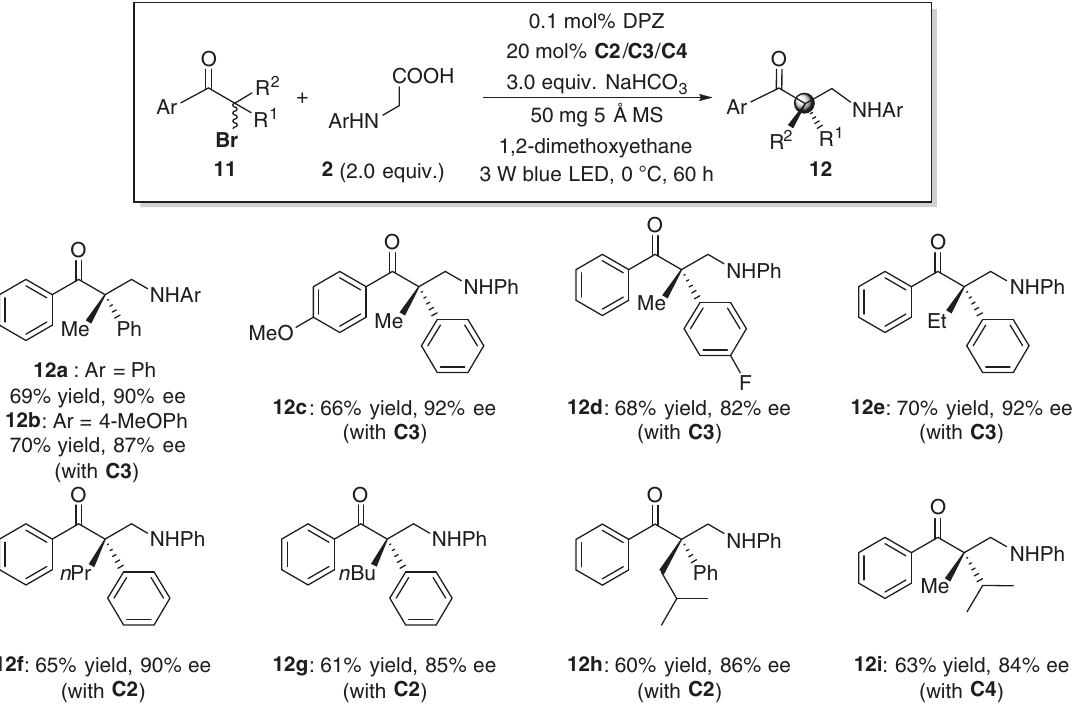
Fig. 4 Substrate scope of tertiary α -bromoketones. Reactions were performed with 7 (0.1 mmol), 2 (0.2 mmol), DPZ (0.1 × 10 − 3 mmol), C2/C3/C4 (0.02 mmol), NaHCO 3 (0.3 mmol), and 5 Å MS (50 mg) in 1,2-dimethoxyethane (1.5 mL) at 0 °C. Yields were determined based on the isolated material after chromatographic puri fi cation. Enantiomeric excesses were determined by HPLC analysis on a chiral stationary